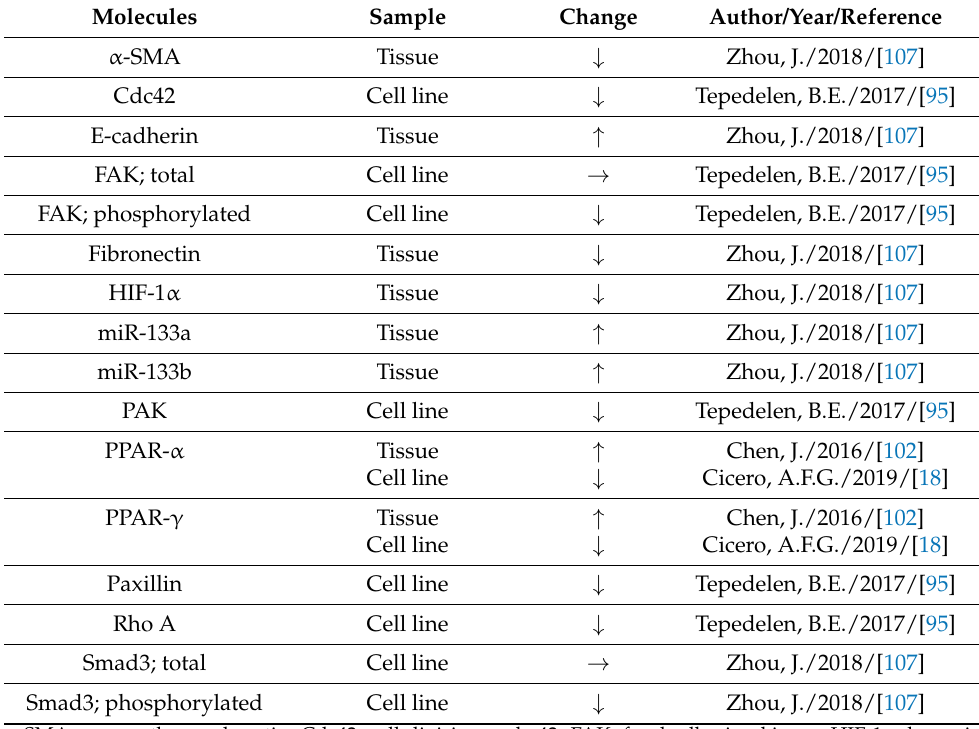
Table 3. Changes of biological factors by green tea